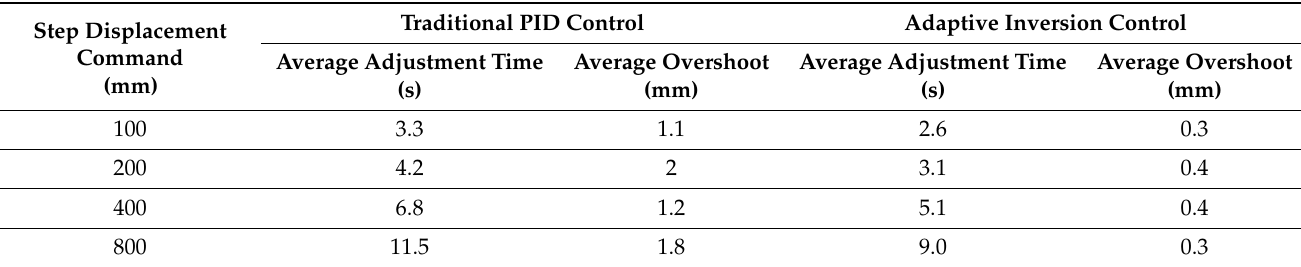
Table 2. Time domain indicators of multistage electromechanical servo